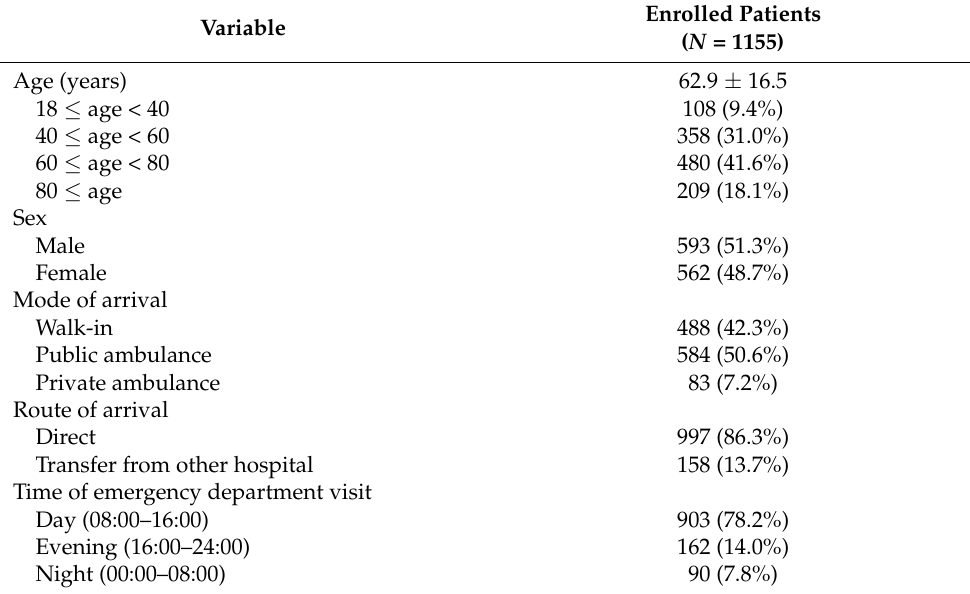
Table 1. Baseline characteristics of the enrolled patients.